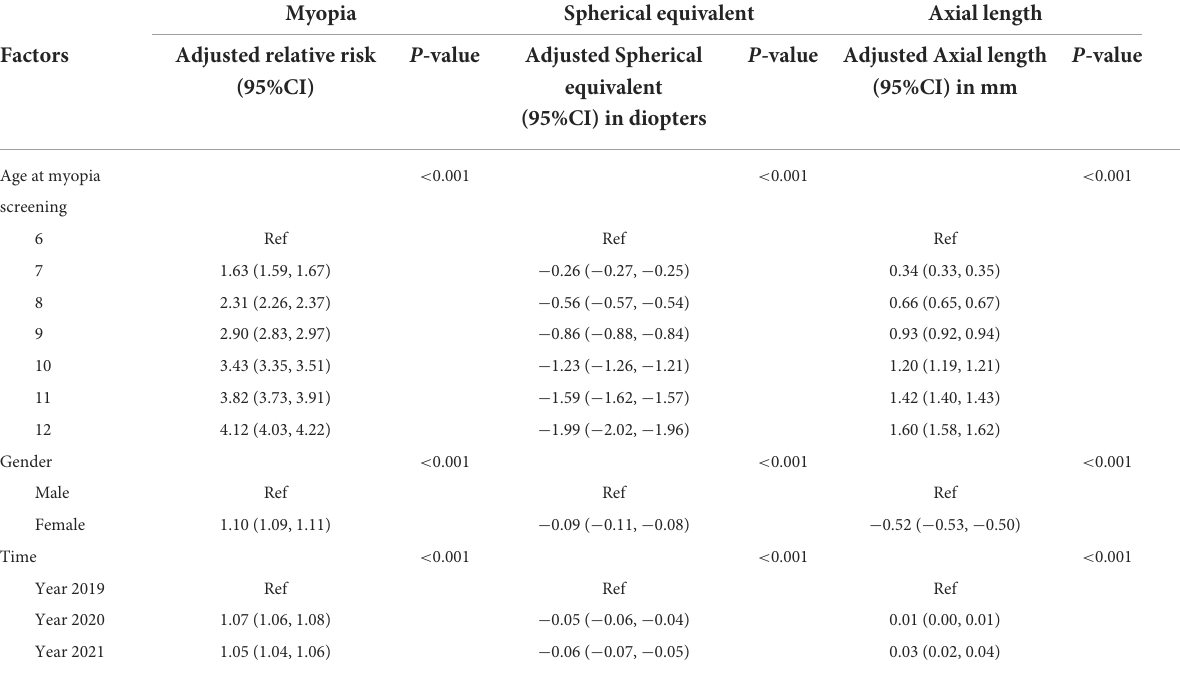
TABLE 4 Multivariable analysis for effect of COVID − 19 lockdown on myopia, spherical equivalent and axial length adjusted by age and gender. Myopia Spherical equivalent Axial length